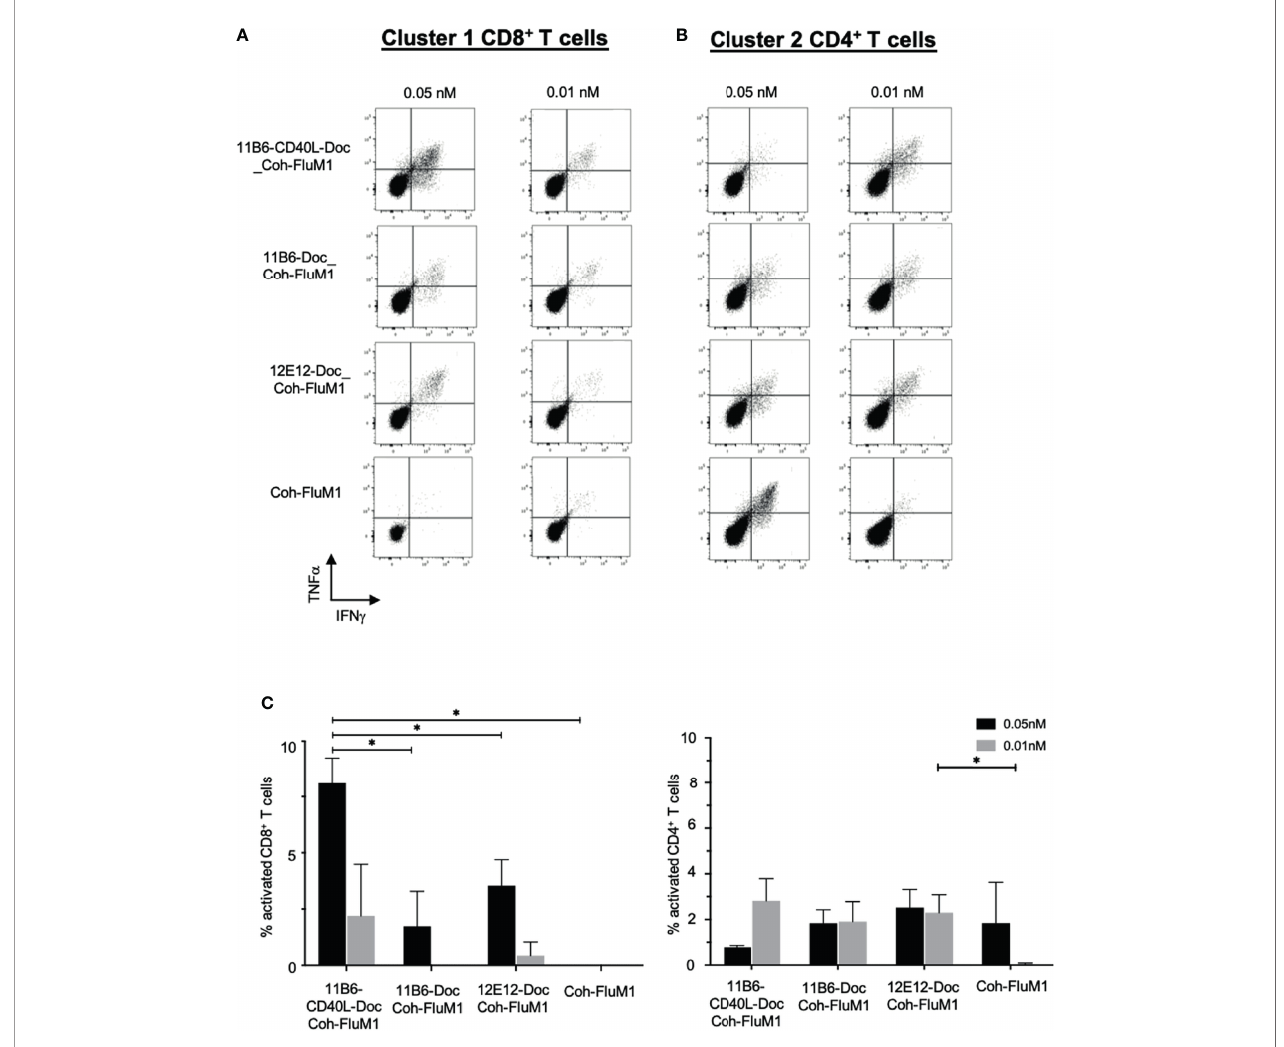
FIGURE 7 | Anti-CD40-CD40L-targeted Flu M1 antigen preferentially expands Flu M1-speci fi c CD8 + T cell responses at low doses in normal donor PBMC cultures. Normal donor PBMCs were cultured for 9 days with IL-2 and a dose range of anti-CD40 vehicles in complex with Flu M1 protein, followed by stimulation with Flu M1 peptide pools for 6 h with Golgi Stop and BFA, then analyzed for intracellular IFN g + and TNF a + by ICS. Results for one representative experiment for CD8 + T cells stimulated with cluster 1 (A) and CD4 + T cells stimulated with cluster 2 (B) are shown. (C) shows repeated experiments with this donor treated with 0.05 and 0.01 nM of the different anti-CD40 vehicles in complex to Flu M1 protein or controls (n=4 for 0.01 nM and n=3 for 0.05 nM); data are represented as n – untreated cells. In all cases anti-hCD40 11B6-CD40L gave more robust CD8 + T cell responses at these low concentrations (mean = 9.1% ± 2 at 0.05 nM and = 3.8% ± 4.4 at 0.01 nM) than the other conditions (mean = 2.9% ± 2.4 at 0.05 nM and = 1.3% ± 0.6 at 0.01 nM). Previous studies [(6); Figure 5 ] have demonstrated that additional Coh-Flu M1 and hIgG4-Doc: Coh-Flu M1 non-targeting controls gave similar minimal responses compared to CD40-Doc: Coh-Flu M1. Supplemental Table 2 shows in detail each In fl uenza Matrix 1 peptide used and how they are grouped into three clusters. * indicates a statistically signi fi cant difference of